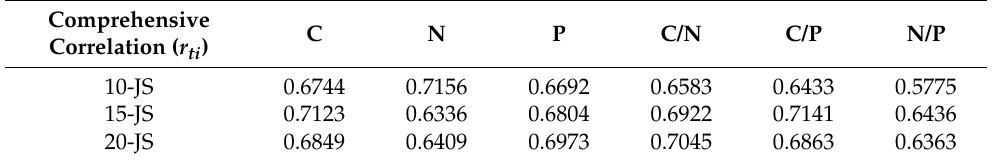
Table 3. Comprehensive correlation between soil factors and Cynodon factors under different precipitation patterns.